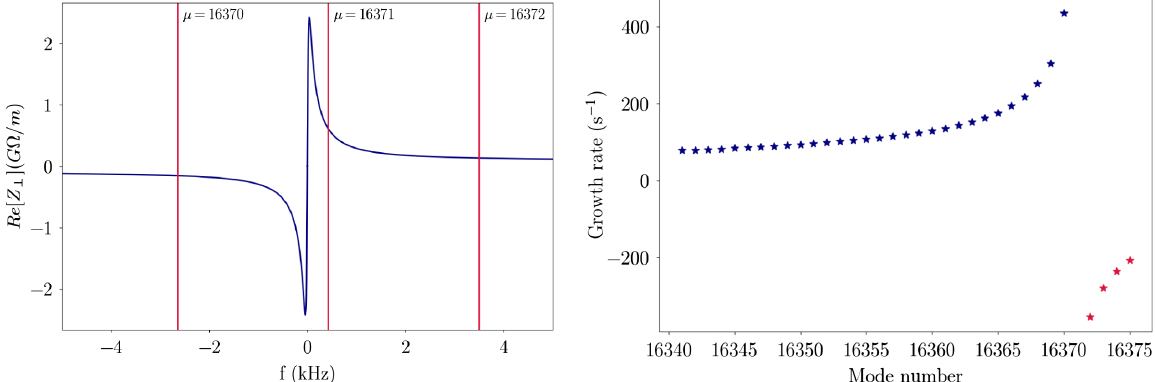
FIG. 11. Vertical coupled bunch spectrum, obtained by using the machine parameters of Table I at the lowest energy, and real part of the resistive wall impedance for a copper beam pipe of 35 mm without coating, as a function of frequency around f ¼ 0 (left side), and growth rate of the coupled bunch modes with azimuthal mode number m ¼ 0 (right